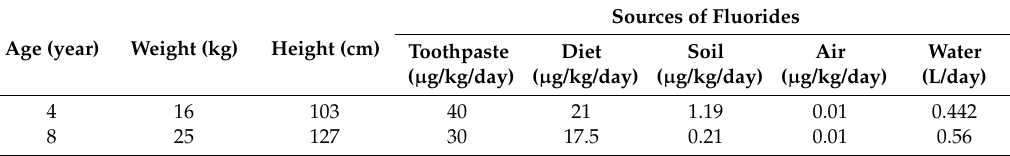
Table 2. Age-specific fixed parameter values needed to model fluoride